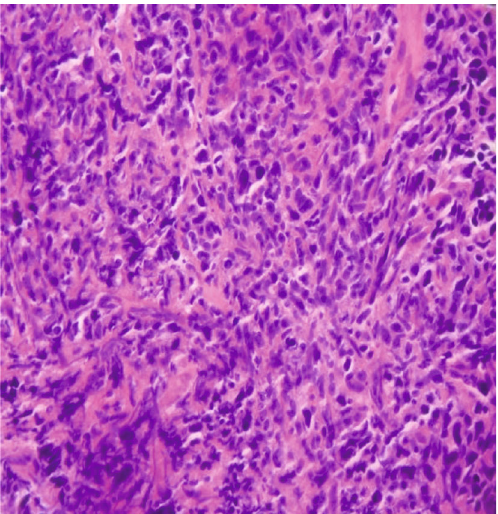
Figure 4: Immunohistochemical stains show that the majority of cells in the specimen are CD20-positive B cells. There is background smaller CD3-positive T-cells. Overall, the fi ndings are most consistent with a di ff use large B cell